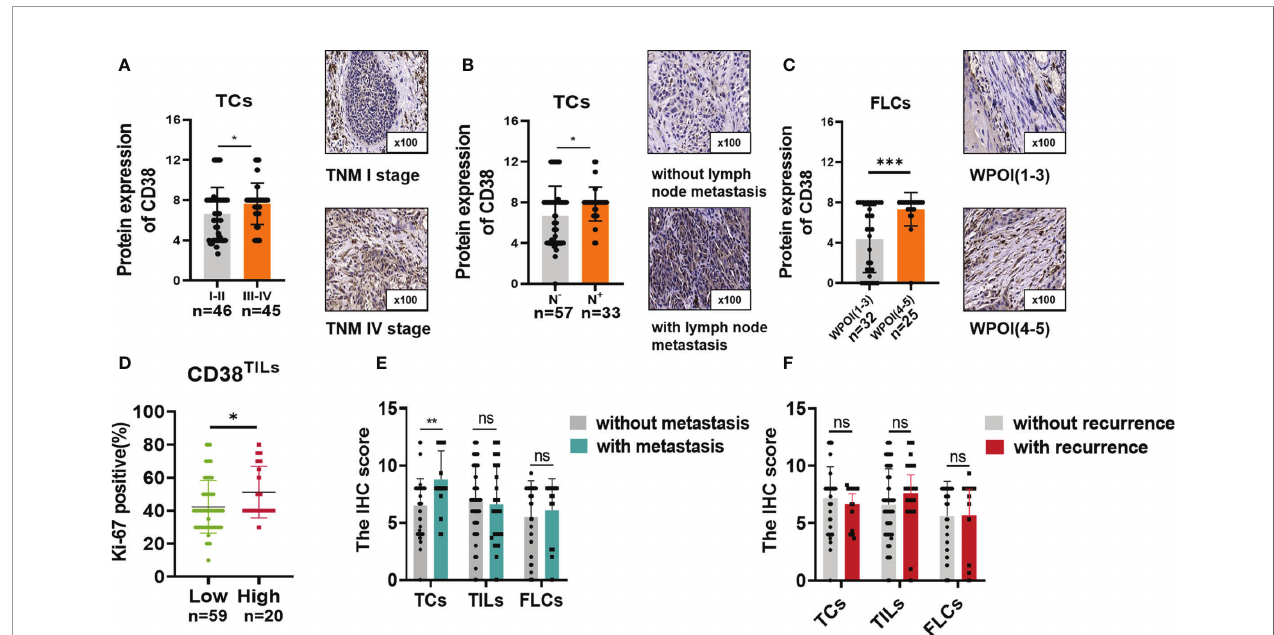
FIGURE 2 | CD38 expression with (A) different TNM stages and (B) lymph node metastasis in TCs and (C) different WPOIs in FLCs. Correlation between Ki-67 staining and CD38 TILs levels (D) . Correlation between CD38 expression and metastasis status in TCs, TILs, and FLCs (E) . Correlation between CD38 expression and recurrence status in TCs, TILs, and TILs (F) . *,**,*** represented that differences were considered statistically signi fi cant with P < 0.05, P < 0.01 and P < 0.001 espectively, and ns reprented no statistical